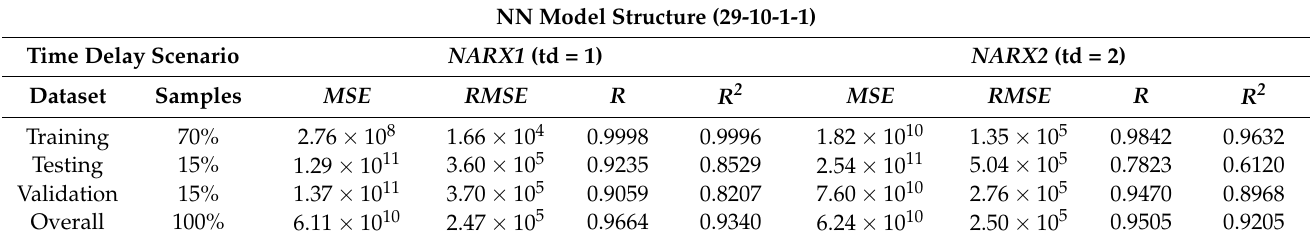
Figure 7. Simulation output of ( a ) NARX1 (td = 1) and ( b ) NARX2 (td = 2). Table 1. Performance evaluation of the NARX-NN scenarios.